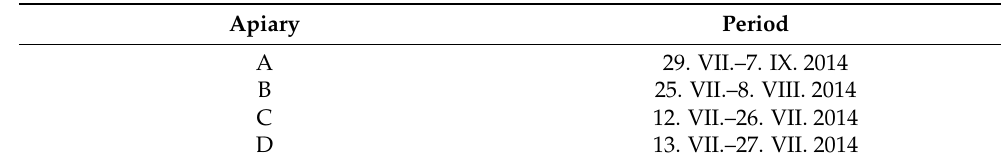
Table 2. Period of winter stores supplementation at individual apiaries. Dates represent intervals during which the tested feeds were